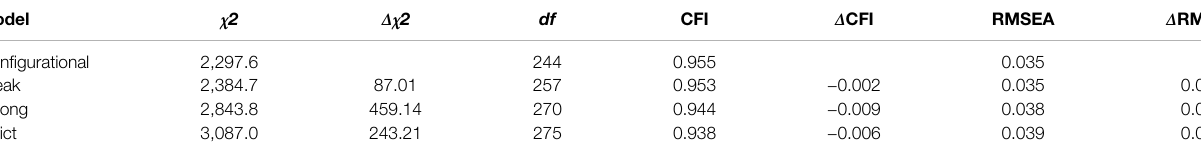
TABLE 4 | Comparison of fi t indices among nested ERECVE